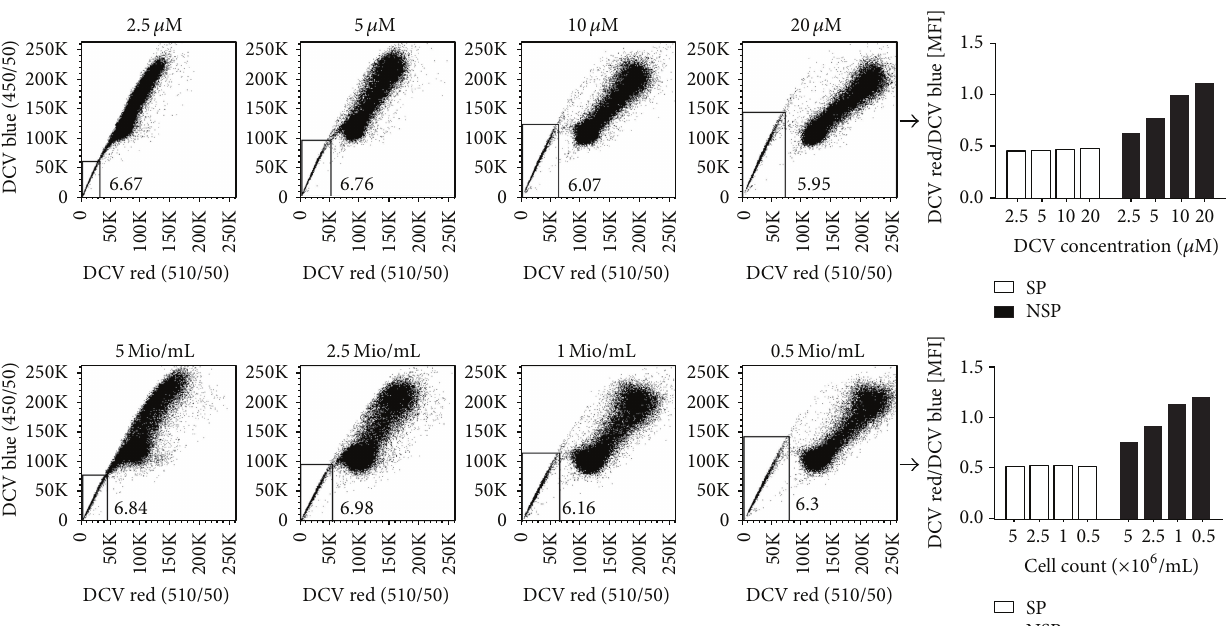
Figure 2: Impact of dye concentration and staining cell density on the separation of DCV-SP cells. A2780V cells were stained either with differentDCVconcentrationsatafixedcelldensity(i.e.,10 6 cells/mL;upperpanels)orwithafixedDCVconcentration(i.e.,10 𝜇 M)atdifferent cell densities (lower panels). Both a high DCV concentration and a low staining cell density promote the separation of SP cells, as outlined by the increasing sizes of the rectangular gates. Note that panels “10 𝜇 M” and “1Mio/mL” correspond to each other (10 𝜇 M DCV and 10 6 cells/mL, resp.). Importantly, improved separation of SP cells at higher dye concentration or lower cell number is primarily due to increased fluorescence of NSP cells in the long-wave range of DCV emission (“DCV red”) (bar